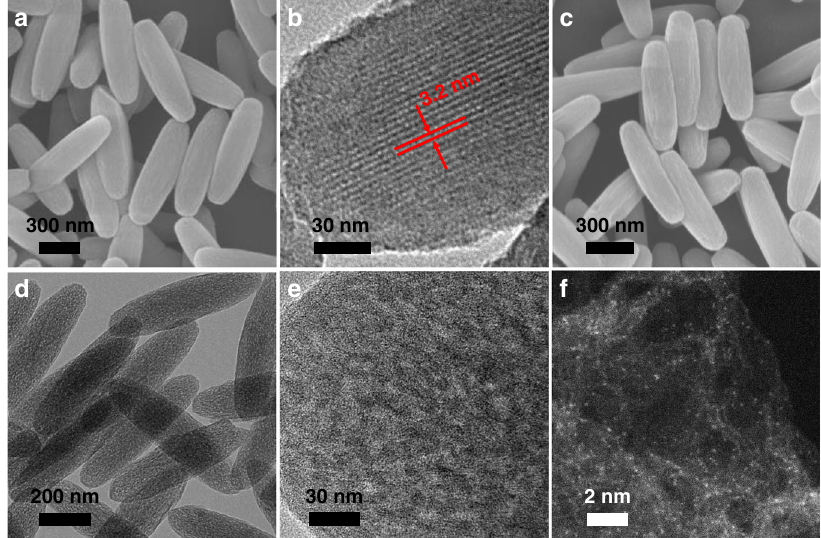
Fig. 2 Microscopic characterizations. a Scanning electron microscopy (SEM) and b transmission electron microscopy (TEM) images of PCN-222(Fe). c SEM and d TEM images of Fe SA – N – C. e Enlarged TEM image showing the mesoporous structure of Fe SA – N – C. f Aberration-corrected HAADF-STEM image of Fe SA – N –